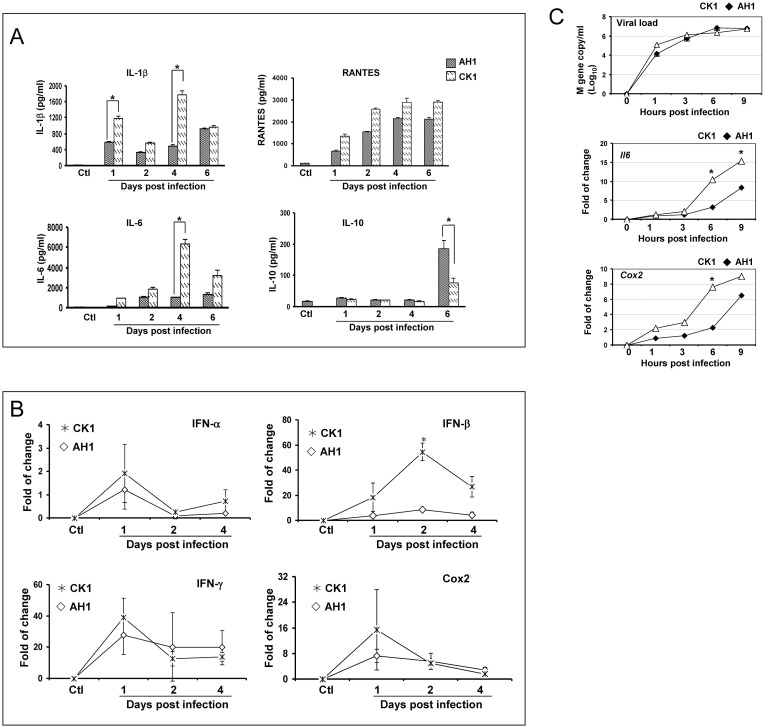
Cytokines and COX-2 expression in infected mice lung and mouse lung epithelial cell line LA-4.(A) The protein levels of cytokines IL-1β, IL-6, RANTES and IL-10 presented in mouse lung homogenates were determined by ELISA. On day 1, 2, 4 and 6 p.i., the left lungs from infected mice (3–5 mice from each group) were homogenized in 1 ml of MEM medium. Clarified homogenates were used for cytokine detection. Non-infected mouse lung specimens were used as baseline controls. (B) mRNA level of IFN-α, IFN-β, IFN-γ and COX-2 genes in mouse lung were determined by real time RT-PCR. Mouse β-actin mRNA was used for RNA concentration normalization. Error bar indicates ±SD. * P<0.05. C. viral load, IL-6 and COX-2 mRNA levels in CK1- and AH1-infected mouse lung epithelial cell line LA-4 determined by real time RT-PCR. 2×105 cells/per well in 12-well plate were infected with AH1 or CK1 at M.O.I of 2. At indicated times post virus infection, the cells were harvested for RNA extraction and real time RT-PCR detection of viral M gene (top panel) and IL-6 (middle panel) and COX-2 (bottom panel) mRNA. β-actin was used as RNA concentration normalization, and the data presented are the average of two experiments. * P<0.05.